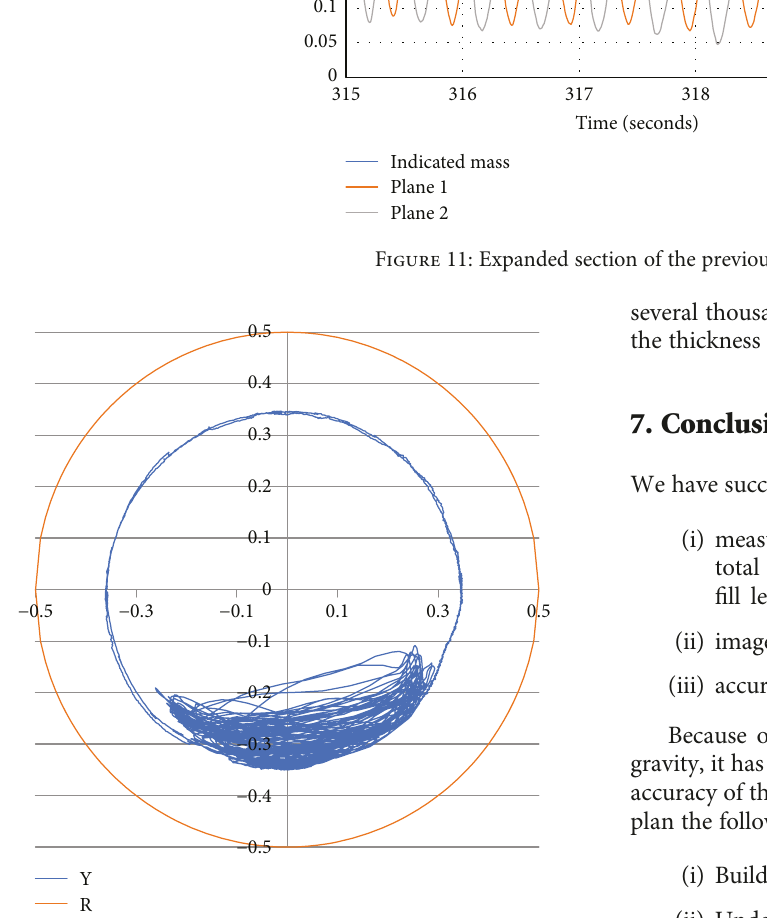
Figure 12: Locus of the centre of mass (CoM) in the X-Y plane for tank 20% full (blue line) with tank internal envelope (orange